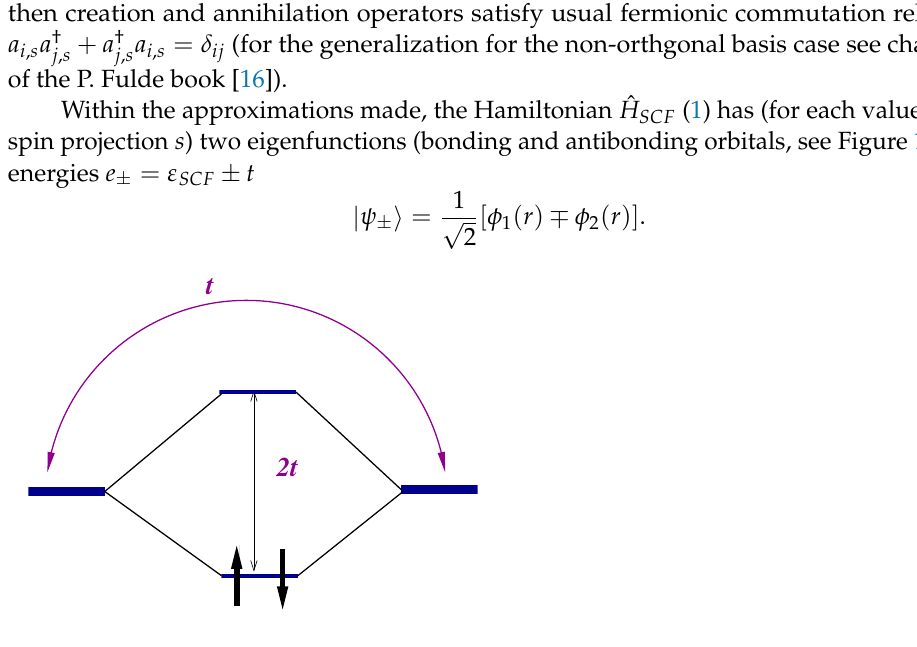
Figure 1. Mean field description of hydrogen molecule electronic